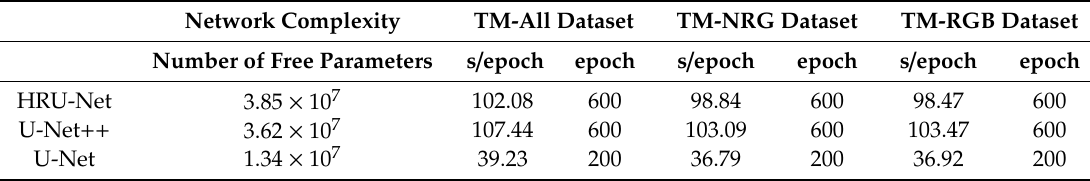
Table 7. The time consumption and network complexity of the training of the HRU-Net, U-Net ++ , and